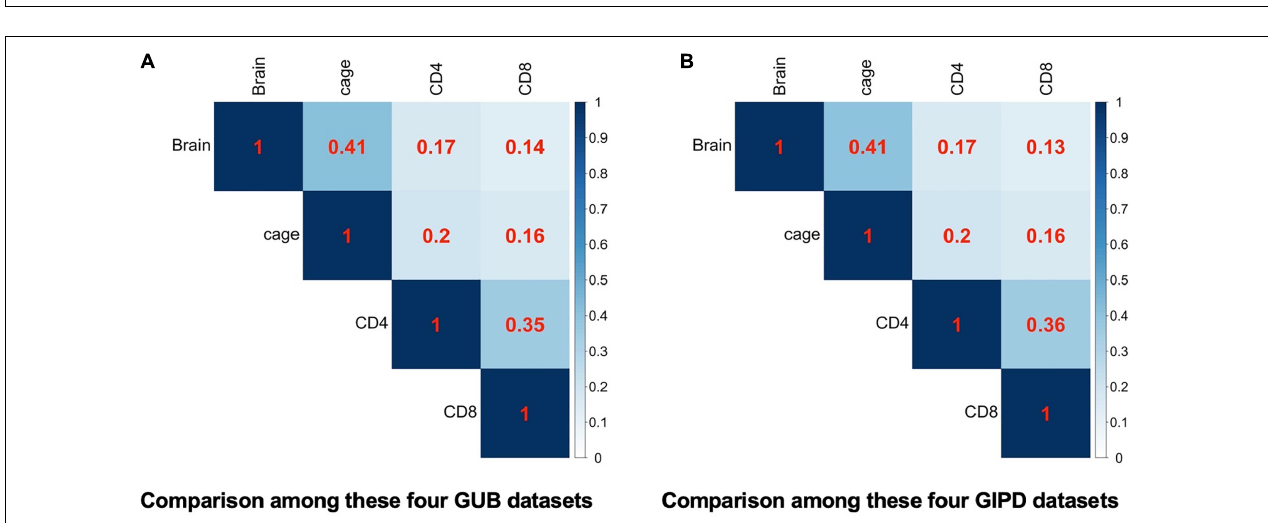
FIGURE 2 | (A) The overlap genes of the GUB_Brain and GIPD_Brain data. 28,142 genes were overlapped. (B) The overlap genes of the GUB_Cage and GIPD_Cage data. There were 19,691 overlapped genes. (C) The overlap genes of the GUB_CD4 and GIPD_CD4 data. These two datasets have 5,656 identical genes. (D) The overlap genes of the GUB_CD8 and GIPD_CD8 data. These two datasets have 4,528 identical genes.